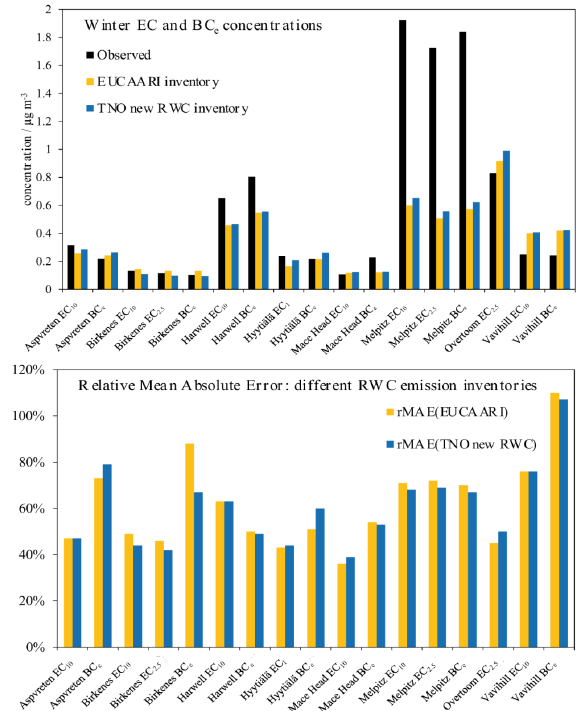
Fig. 11. Comparison of observed EC, and EC-equivalent BC e , to modelled EC, using two different emission inventories for residential wood combustion. Data are from different periods for different stations (see Tables 1 and S3a and S3b). The upper diagram shows average EC or BC e concentrations during winter half-year periods (November-April): Observed (black), Model with EUCAARI emissions (orange), Model with TNO new RWC emissions (blue); unit: μg m -3 . The lower diagram shows the relative mean absolute error (rMAE) for EUCAARI (orange) and TNO new RWC (blue); the rMAE is calculated as the MAE divided by the observed mean concentrations.